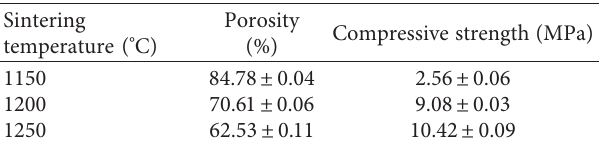
Figure 7: Pore size distribution of steel slag foam ceramics sintered at 1150 ° C, 1200 ° C, and 1250 ° C (a) and mean pore size of steel slag foam ceramics sintered at different temperatures (b) (40 wt.% solid loading). Table 2: Porosity and compressive strength as a function of sin- tering temperature (prepared from 40 wt.% solid